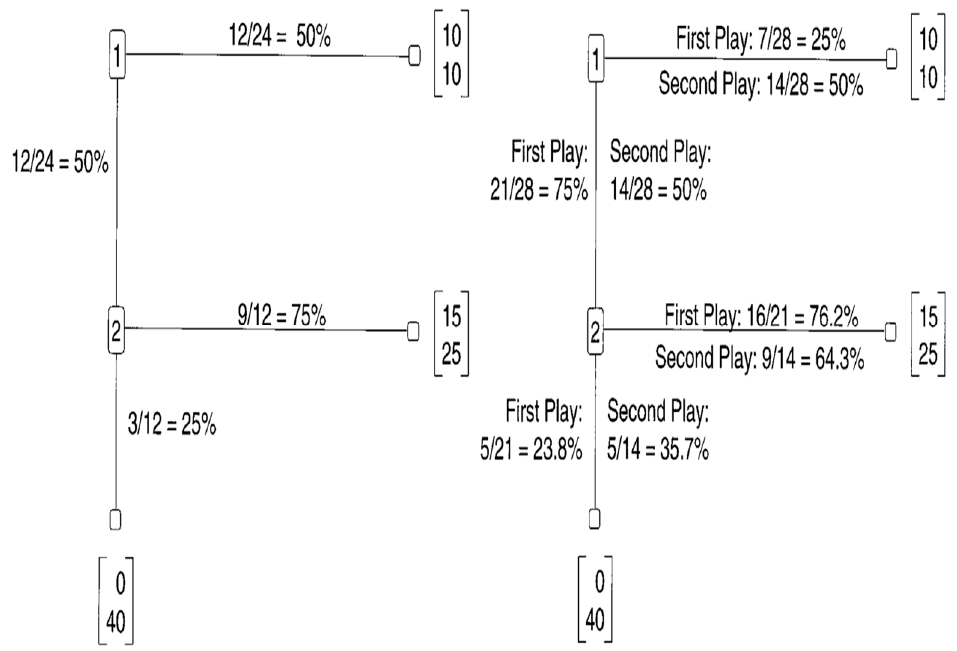
Figure 6. Left panel: Trust game. Single play by undergraduates ( n = 24 pairs). Right panel: Trust game. Played twice by advanced graduate students in economics ( n = 28 pairs). Adopted from [14].